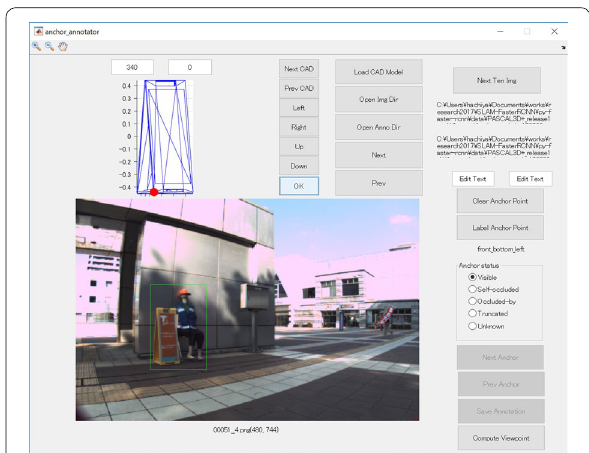
Fig. 17 Capture image of annotation tool